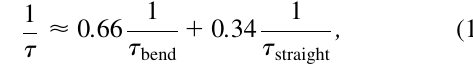
FIG. 14. Top: Emittance evolution for different central cloud densities at an energy of 450 GeV considering a proton beam passing through a straight section. The legend entries indicate the central cloud densities in 1 (cid:2) 10 11 m (cid:1) 3 . Bottom: The cor- responding rise time values with threshold set at 10